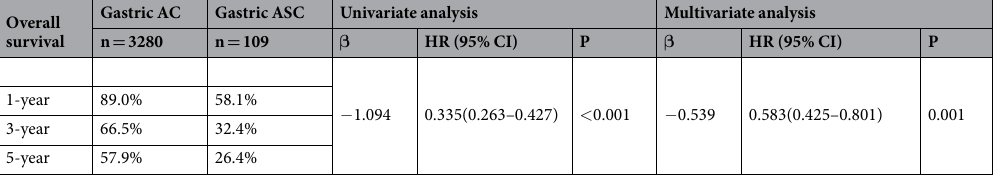
Table 4. Comparative overall survival analysis of gastric AC and ASC using univariate and multivariate analysis.